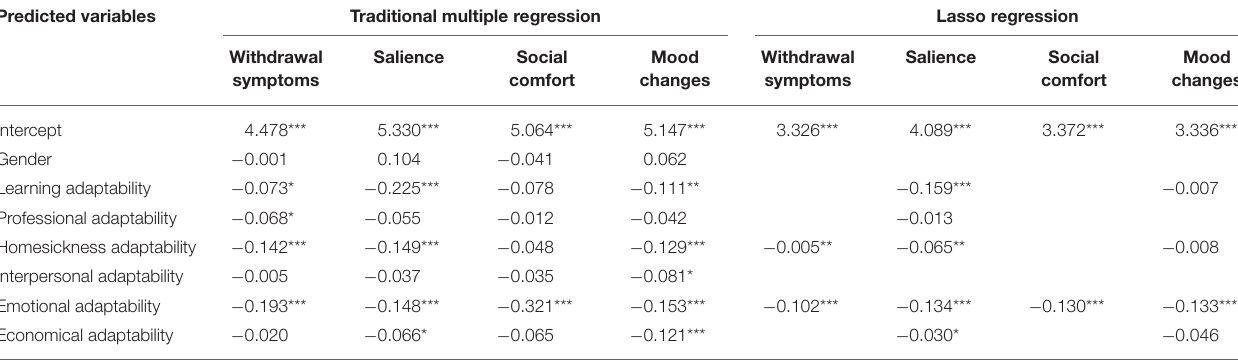
TABLE 4 | Traditional multiple regression and Lasso regression model of mobile phone addiction and adaptability. Predicted